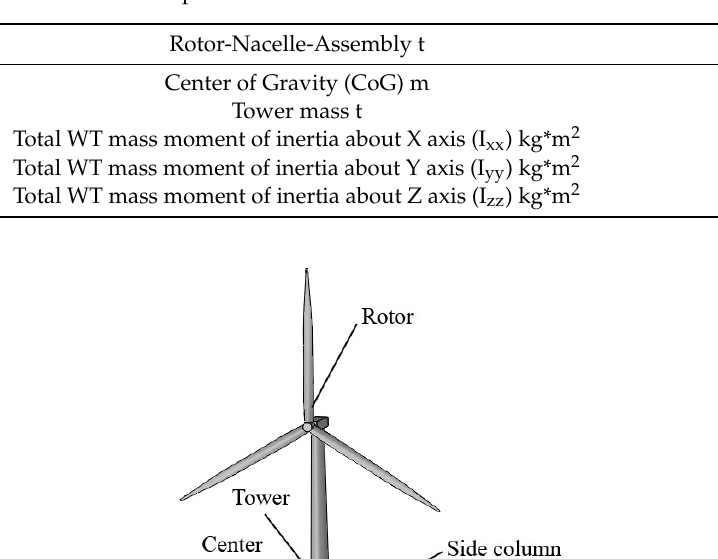
Table 1. The main parameters of the 5-MW wind turbine.